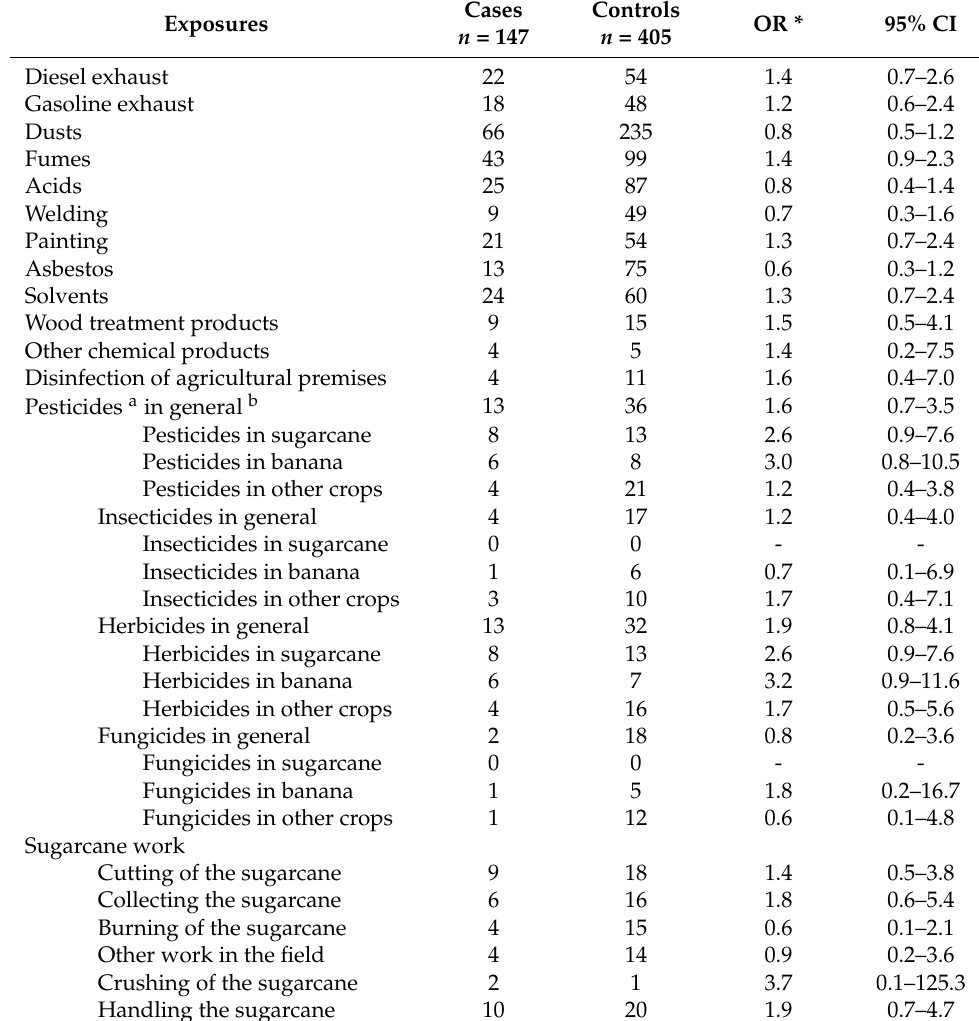
Table 3. Association between occupational exposures and specific tasks and lung cancer risk in the French West